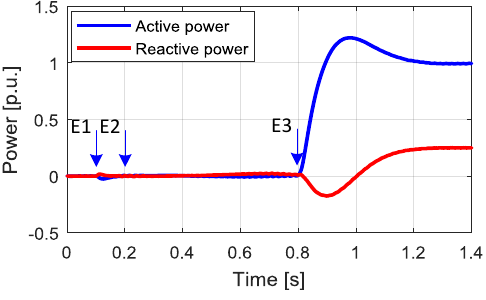
Figure 11. Active and reactive power injected by the power converter during the start-up and power step-up.